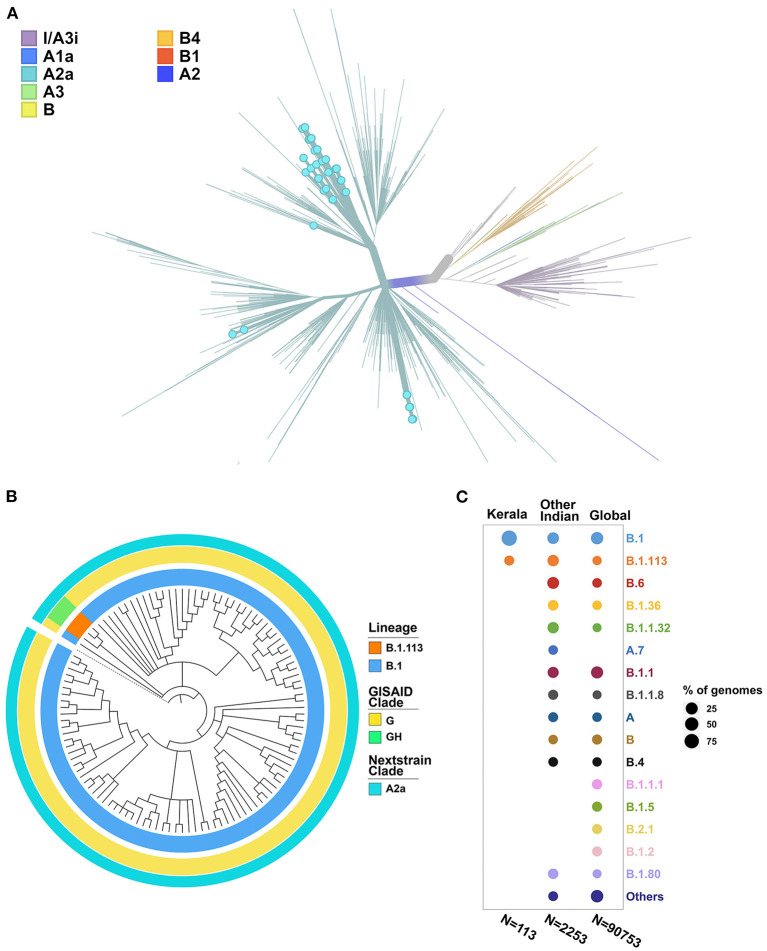
(A) Phylogenetic map of the 113 genomes sequenced from Kerala (highlighted by blue dots) with respect to the other genomes from India. (B) Distribution of the clades and lineages in Kerala. All genomes clustered under the clade A2a (GISAID clade G and GH) while the dominant lineage was B.1. (C) Lineage distribution in Kerala compared to the distribution across India and global populations.